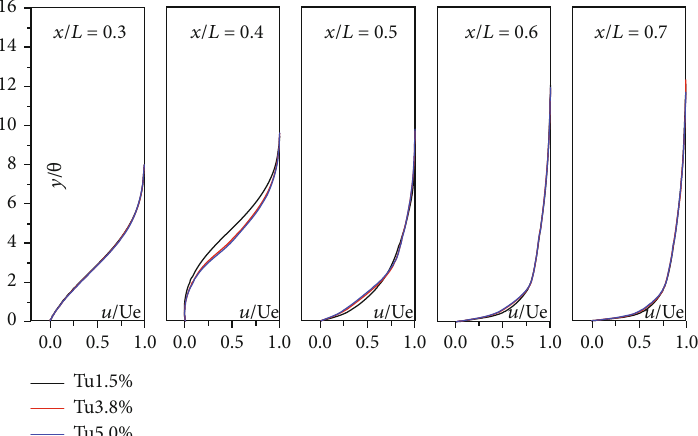
Figure 12: Velocity pro fi le comparison with fi xed Re = 500000